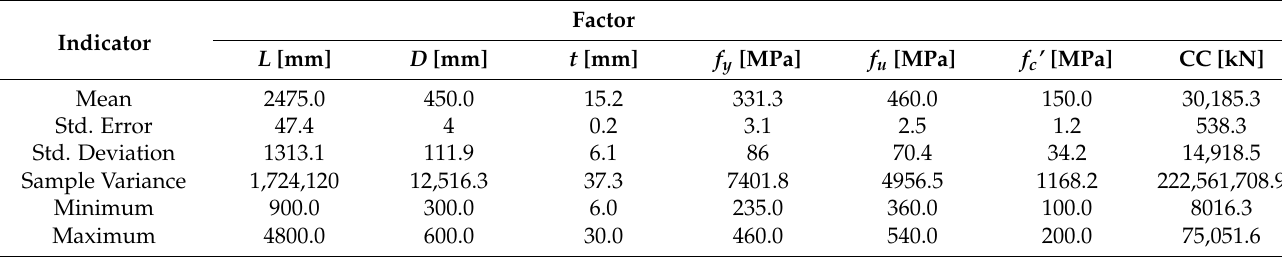
Table 1. Statistical analysis of the CC and influential